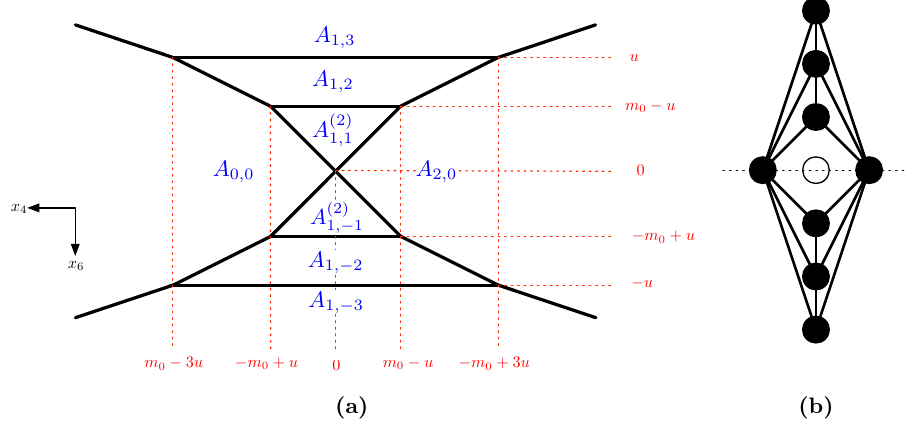
Table 3. The regions where each A ( m ) of the E 1 theory. The second column gives independent relations for ensuring that A ( m ) column becomes the largest. The last column indicates a region in the ( x 4 ; x 6 )-space where the A ( m ) in the (cid:12)rst column becomes the largest. k;l